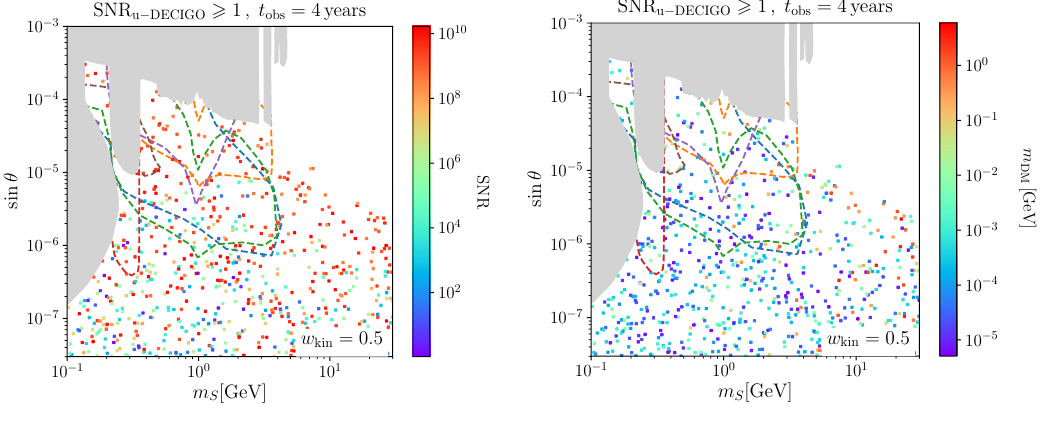
Figure 6 . Same as figure 5 but for w kin = 0 . 5